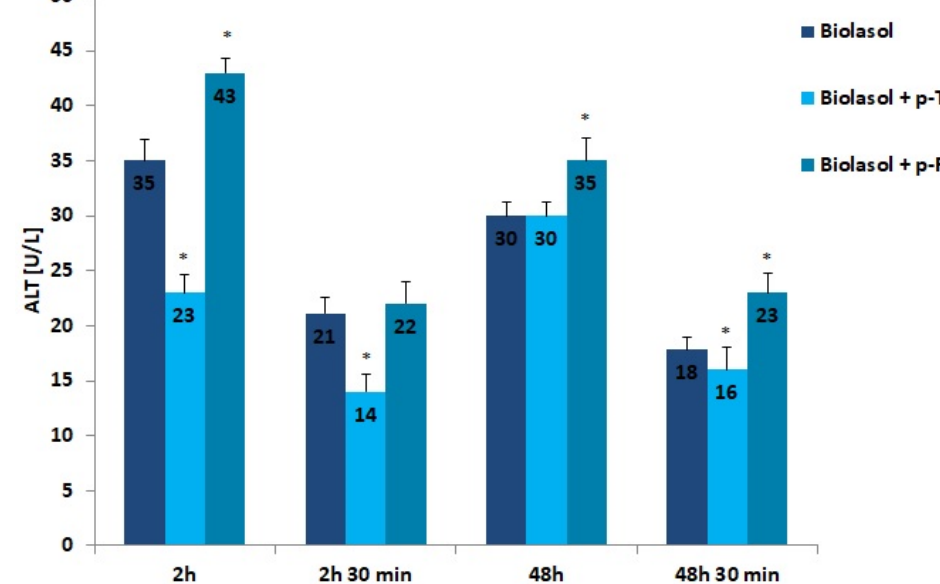
Figure 1. ALT activity in the collected perfusates. The values are expressed as mean ± SEM. * p < 0.05 compared to the control group (Biolasol).